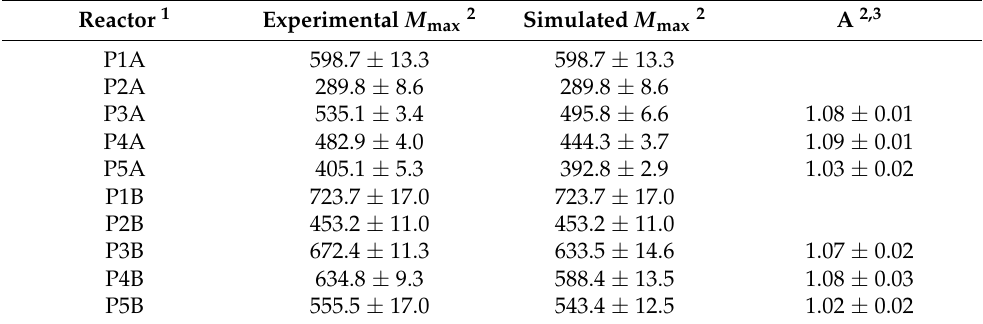
Table 8. Results of the synergistic or antagonistic effect produced by the codigestion of SSW with